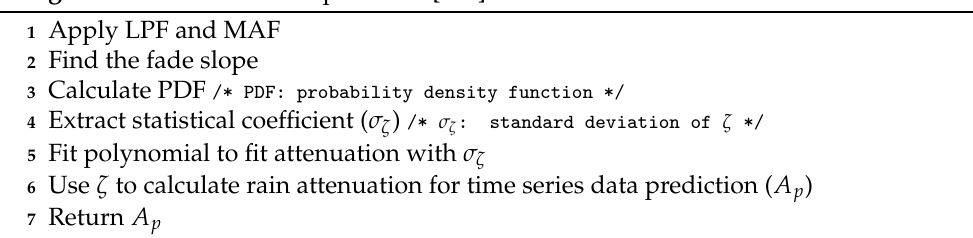
Algorithm 20: Das Fade slope model